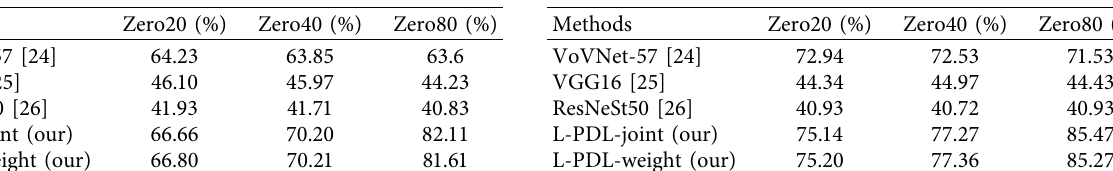
Figure 6: The examples of (a) Zero20, (b) Zero40, and (c) Zero80 on CIFAR-10. Table 3: Result on CIFAR-100. Table 4: Result on